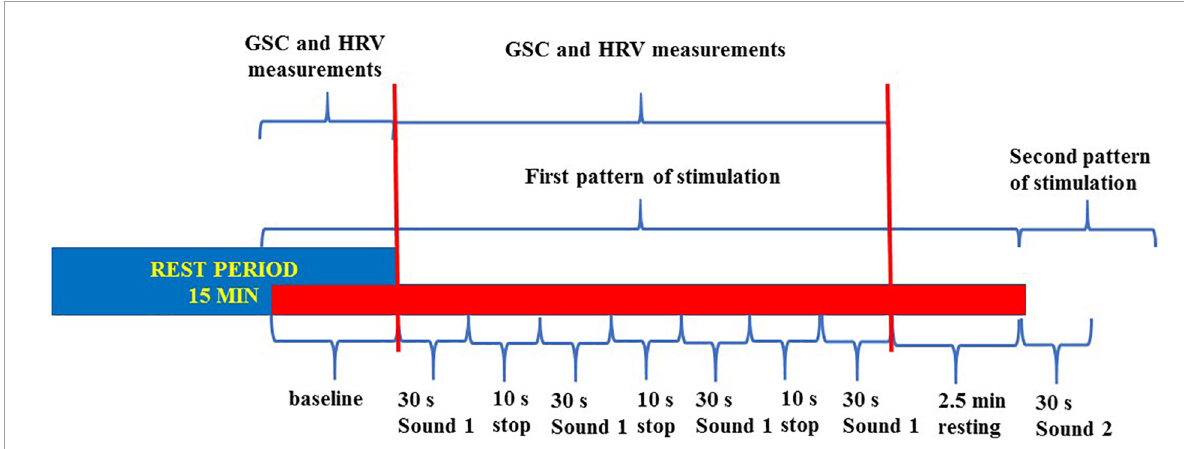
FIGURE1 Flowchart about the trigger sounds protocol. The entire sounds stimulation protocol was made of seven patterns of stimulation (six “trigger sounds” and one “annoyance sound”). All patterns were included in a single track. We measured the baseline GSC and HRV variables during each period of stimulation for comparison with the same values at baseline. GSC, galvanic skin conductance; HRV, heart rate